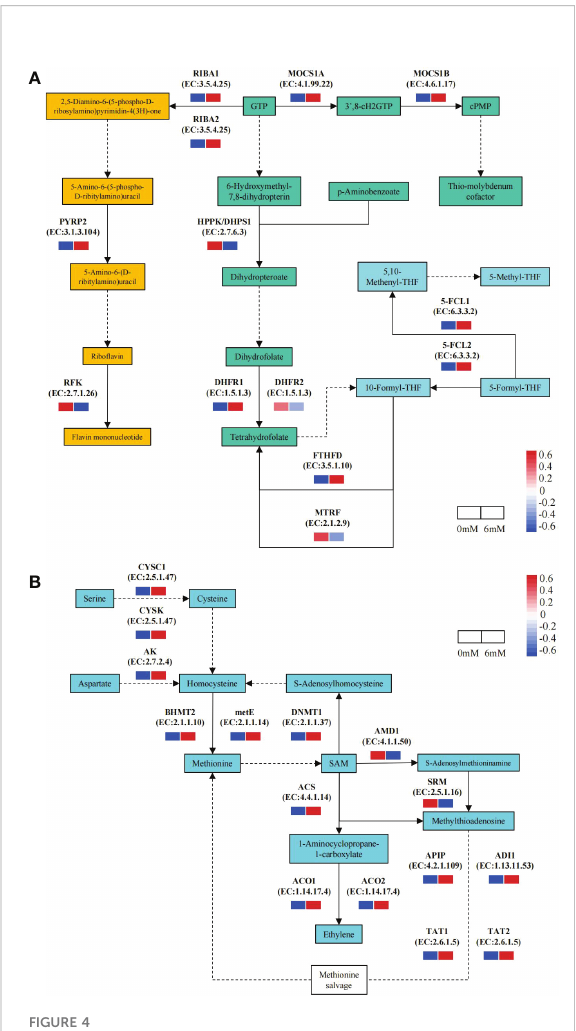
FIGURE 4 The expression pattern of DEGs related to the folate and Met metabolic pathway the squares represent the metabolites in the folate metabolism pathway; Yellow background indicates genes in the ribo fl avin metabolic pathway, green background indicates folate synthesis pathway genes; blue background shows folate- dependent 1C metabolism pathway; solid and dotted line arrow indicated directly and indirectly products synthesis route by downstream enzyme and substances. (A) : PYRP2: 5-amino-6-(5- phospho-D-ribitylamino)uracil phosphatase; RFK: bi-functional ribo fl avin kinase; RIBA1/RIBA2;bi-functional ribo fl avin biosynthesis protein; MOCS1A/1B: GTP 3 ’ ,8-cyclase;